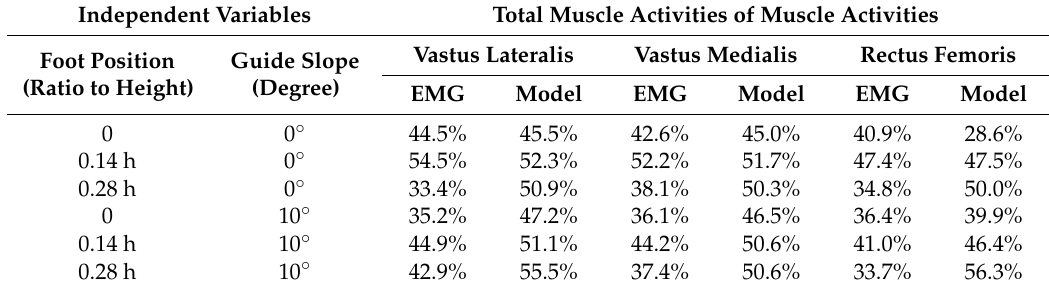
Table 5. Total muscle activities of right leg measured by EMG sensors and simulated by AnyBody. Independent Variables